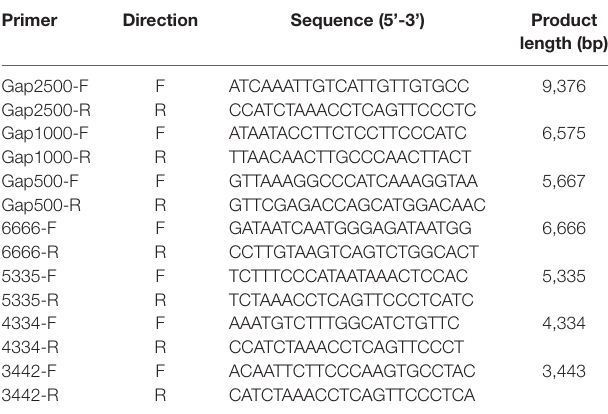
TABLE 1 | Gap-PCR primers.